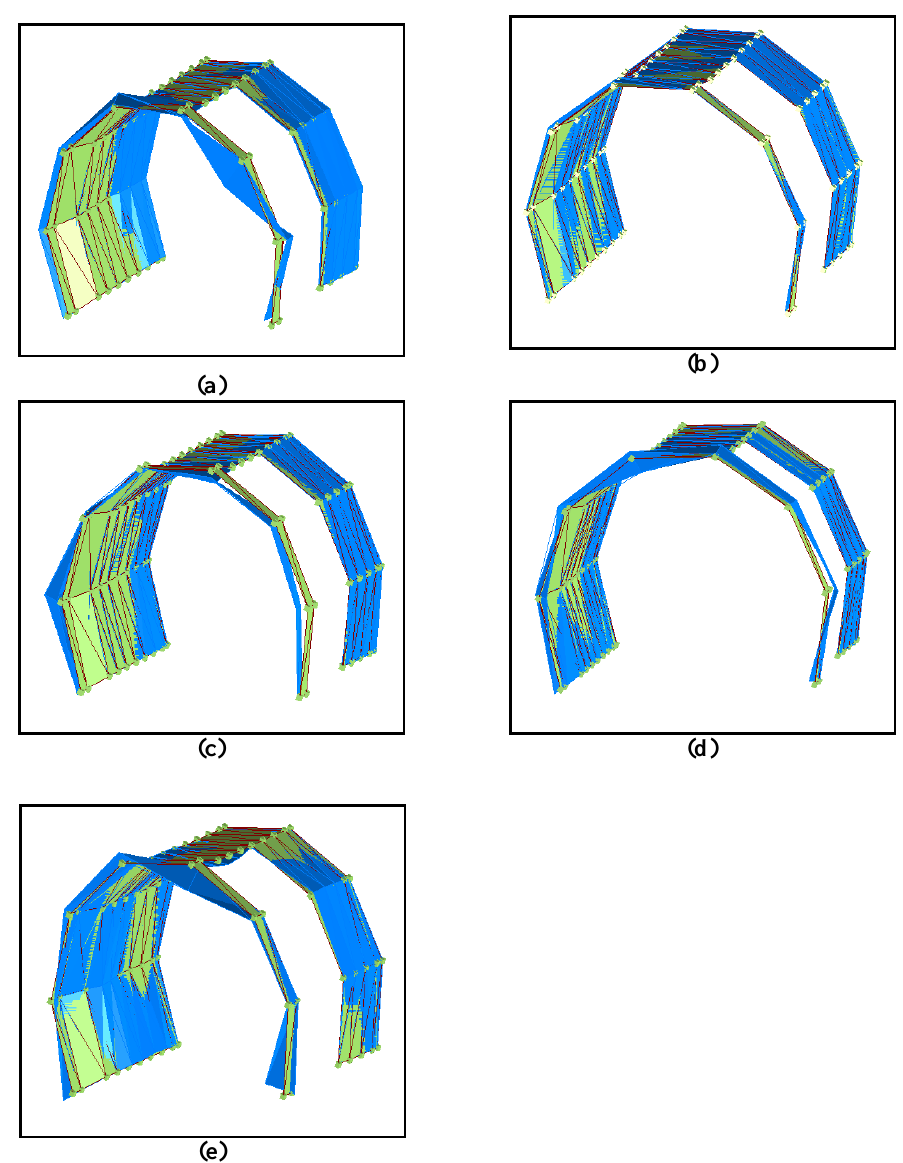
Figure 6. Operating deflection shape at ( a ) 424 Hz, ( b ) 1164 Hz, ( c ) 1439 Hz, ( d ) 1943 Hz, and ( e ) 2787 Hz.